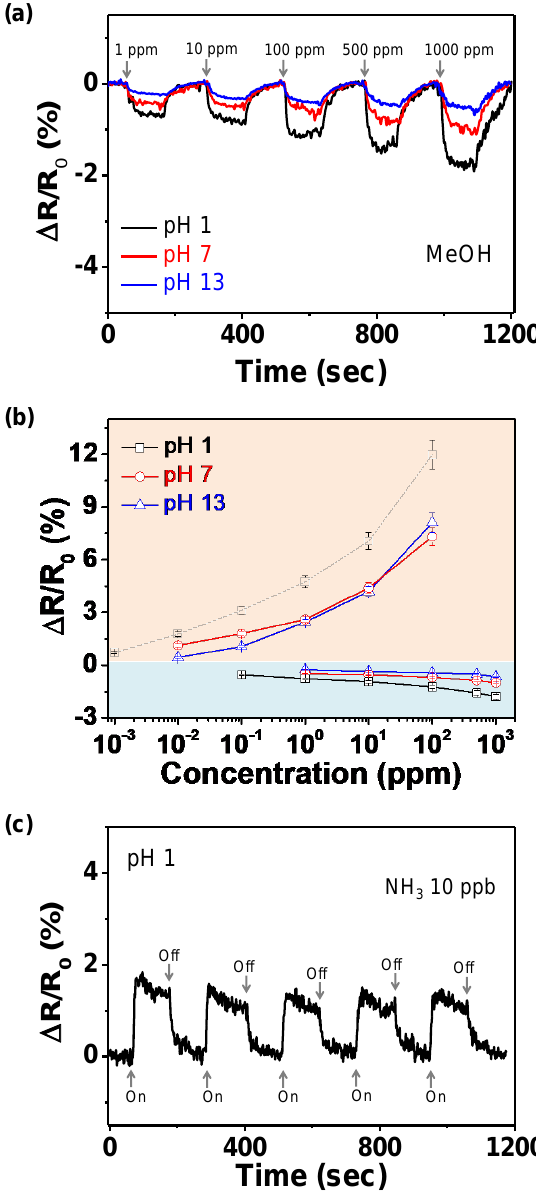
Figure 8. ( a ) Change in normalized resistance with different MeOH concentrations. ( b ) Calibration curves of PPyNPs as functions of NH 3 and MeOH concentrations; black for pH 1, red for pH 7, and blue for pH 13. ( c ) Periodic exposure of PPyNPs treated at pH 1 to 10 ppb of NH 3 gas.